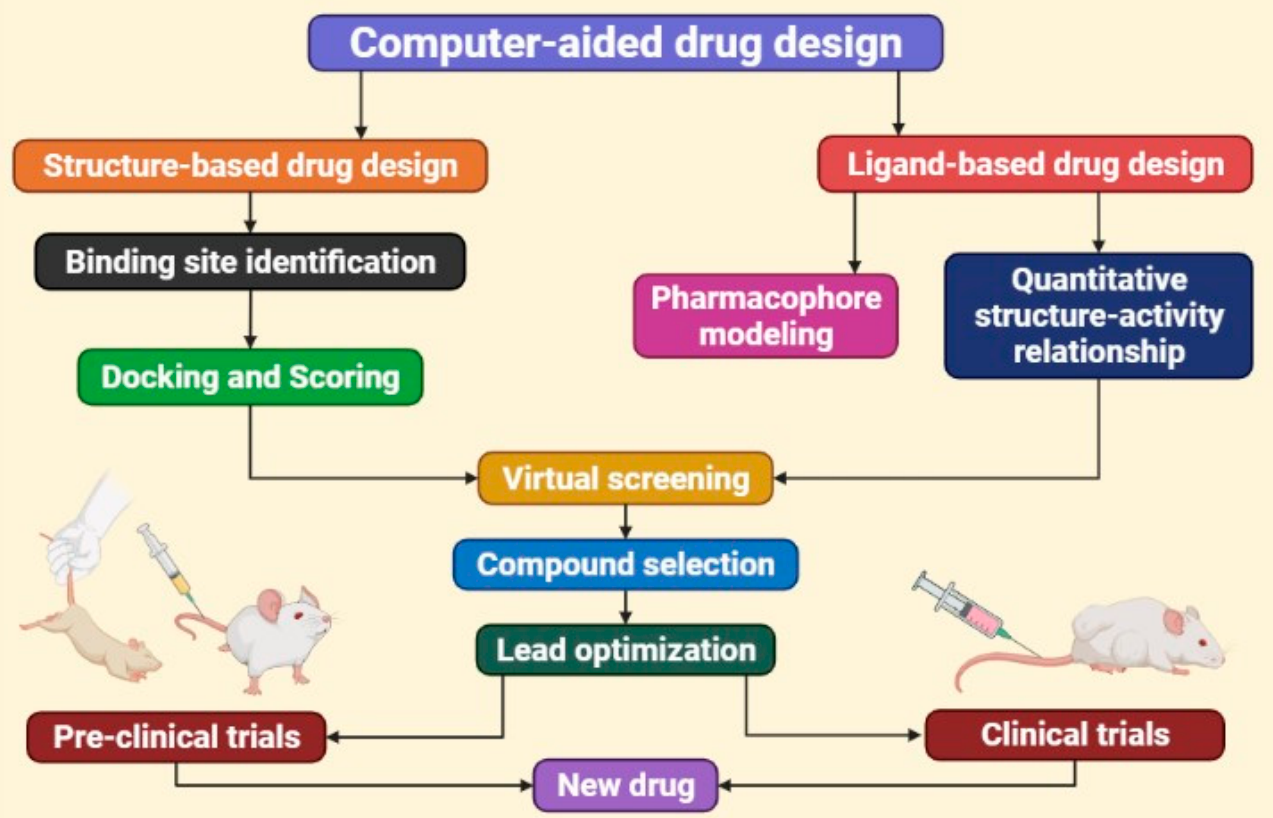
Figure 1. New drug development process using computer-aided drug design approach.